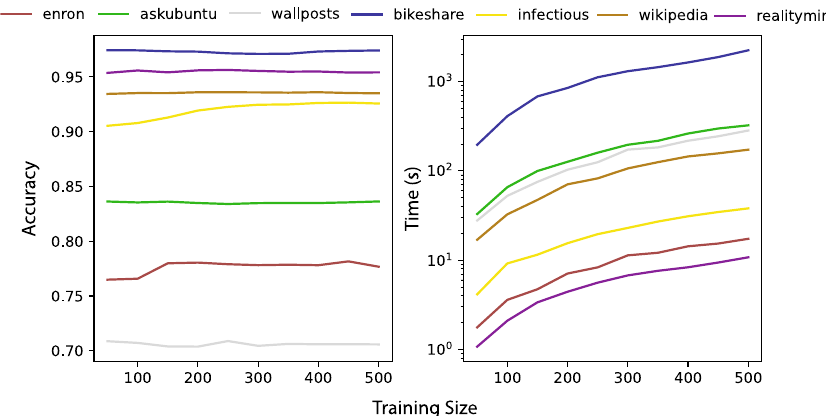
Fig. 6 Prediction accuracy and computation time for the dual linear regression model as the number of training slices is varied. On most data sets, the prediction accuracy does not significantly increase as the training size is increased, so using more training slices has minimal benefit